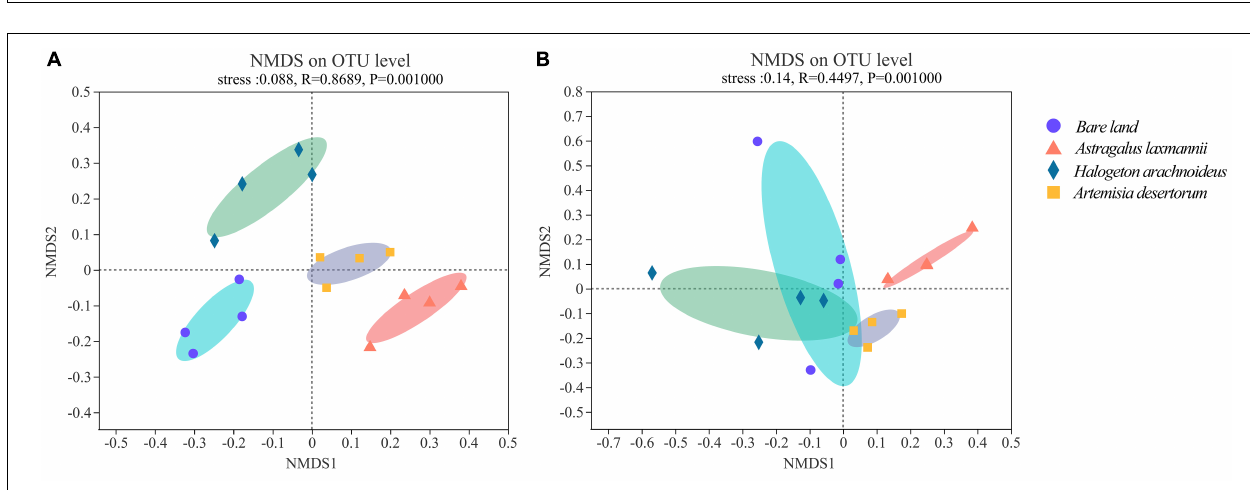
FIGURE 3 | Richness of (A) bacterial and (B) fungal communities in soils from bare land and those re-vegetated with different plant species. Different lower-case letters indicate significant differences based on least significant difference tests.